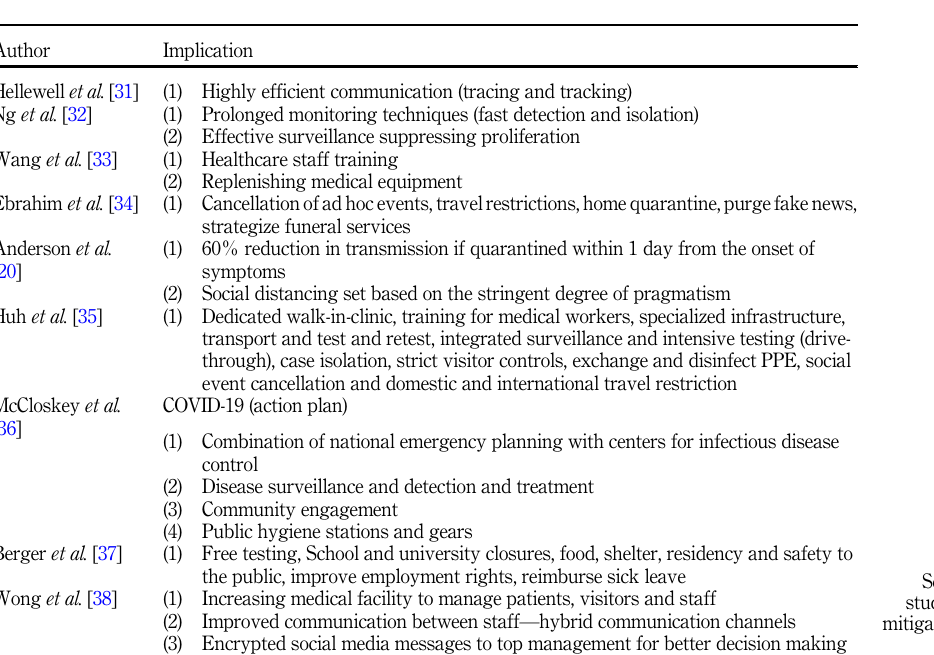
Figure 2. Publication